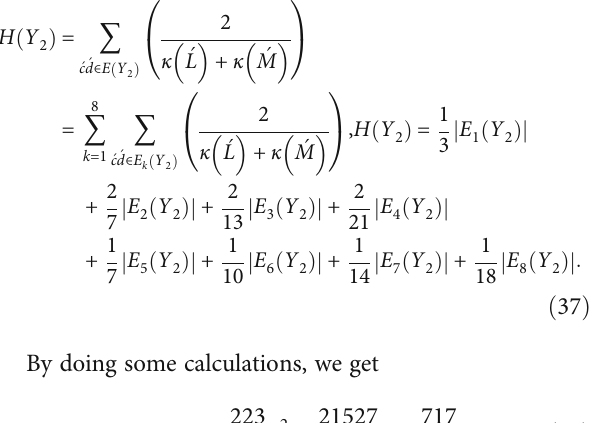
Figure 9: Comparison of indices for RHDN4 ð 4, 4 Þ